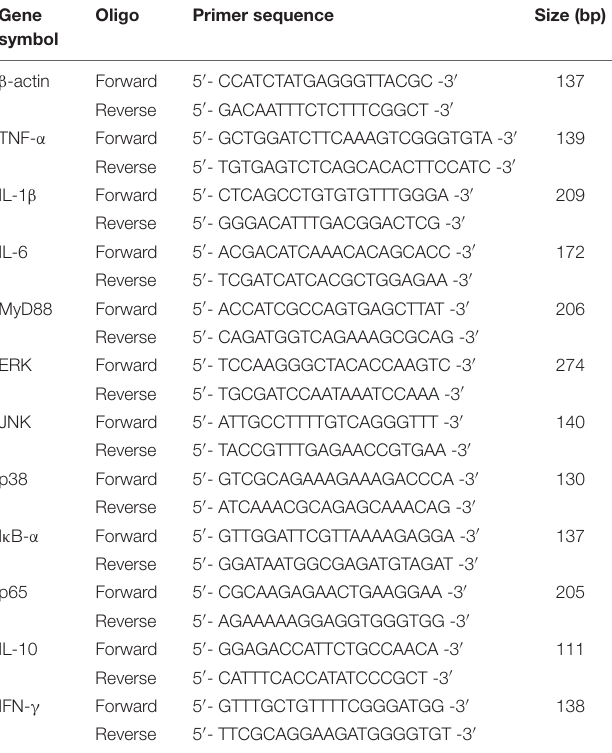
TABLE 1 | Primer sequences for the RT-PCR assay. TABLE 2 | Quantitative results of the effects among each experimental group demonstrating zebrafish inflammation ( n =